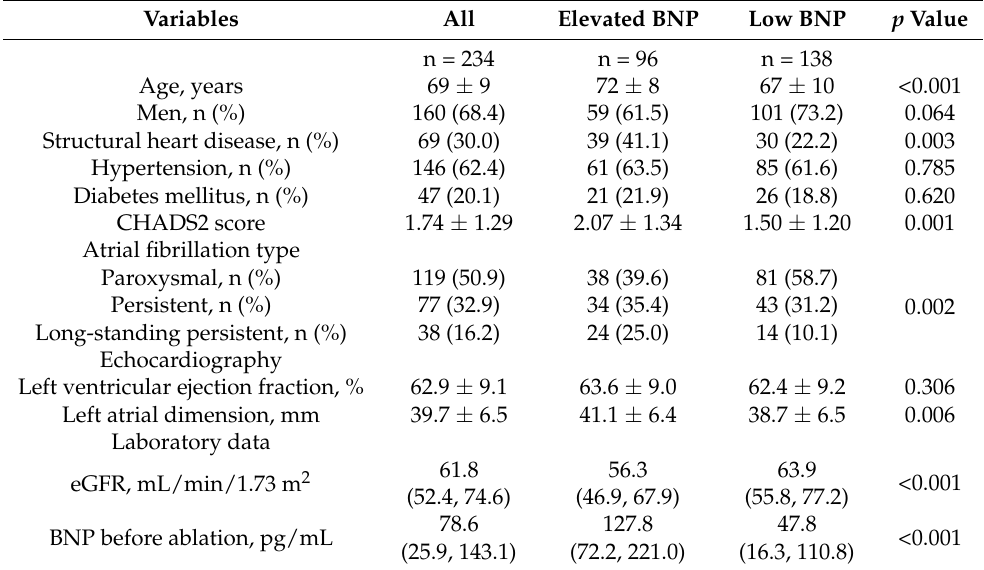
Figure 1. The area under the curve for brain natriuretic peptide (BNP) levels 3 months after the procedure (green) and before the procedure (blue) were 0.714 and 0.593, respectively. Table 3. Comparison of patient characteristics between patients with elevated and low BNP